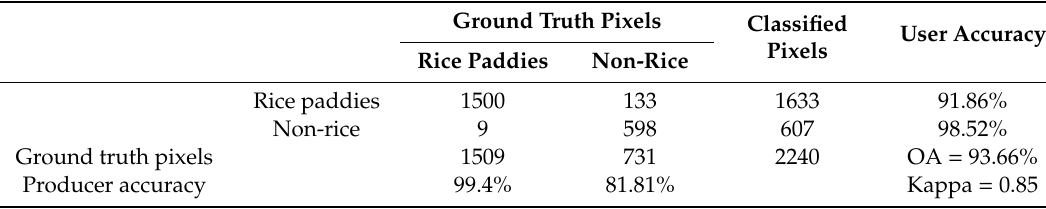
Table 1. Confusion matrix between ILMP-Rice in Nanchang County and the validation points from the high-resolution images via Google Earth and in-situ data.